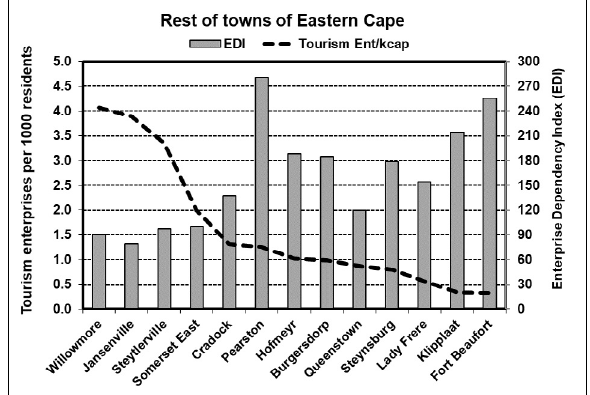
Comparison of the tourism and hospitality sector strength (tourism enterprises/1000 capita and expressed as Tourism Ent/kcap) and the enterprise dependency indices (EDIs) of other towns in the Eastern Cape. The T&H sector strengths of the towns on the N1 national road (Figure 1) are somewhat lower than those of Route 62 towns but are higher than those of the towns of the N9 national road (Figure 9). The strengths of the T&H sector of the towns close to the Square Kilometre Array (SKA) development (i.e. Carnarvon and Williston) are somewhat higher than those of the N1 towns. Sutherland seems to be benefiting much from its astronomy attractions and Loxton from its association with Deon Meyer, a well-known Afrikaans crime novelist. These towns have relatively low community poverty (EDIs).